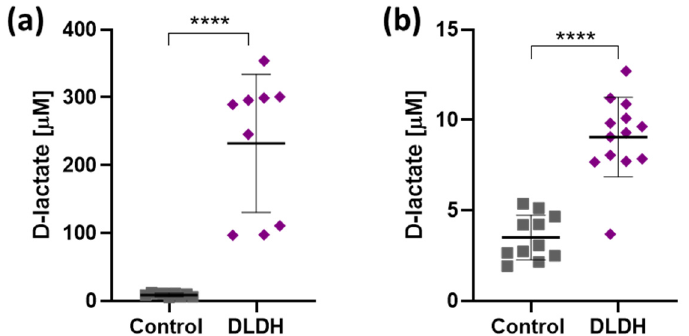
Figure 4. Constitutive D-lactate release from cells expressing DLDH. ( a ) Media conditioned by non-transfected HEK293 cells (Control, n = 9) and HEK293 cells transfected with 1.5 µ g/ µ L of pTYF-EF1 α -DLDH-IRES-EGFP (DLDH, n = 9). ( b ) Media conditioned by non-transduced cultured astrocytes (Control, n = 11) and astrocytes transduced with AVV-sGFAP-DLDH-IRES-tdTomato (DLDH, n = 13). **** p < 0.0001, unpaired two-tails t